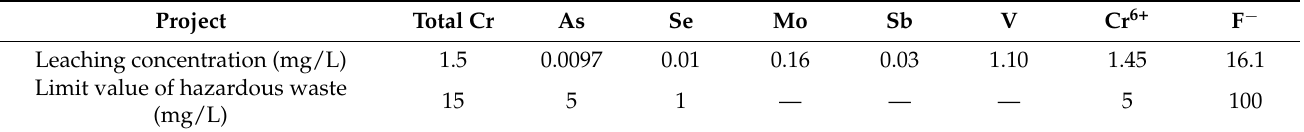
Table 2. Leaching concentrations of some harmful elements from Bayer red mud.